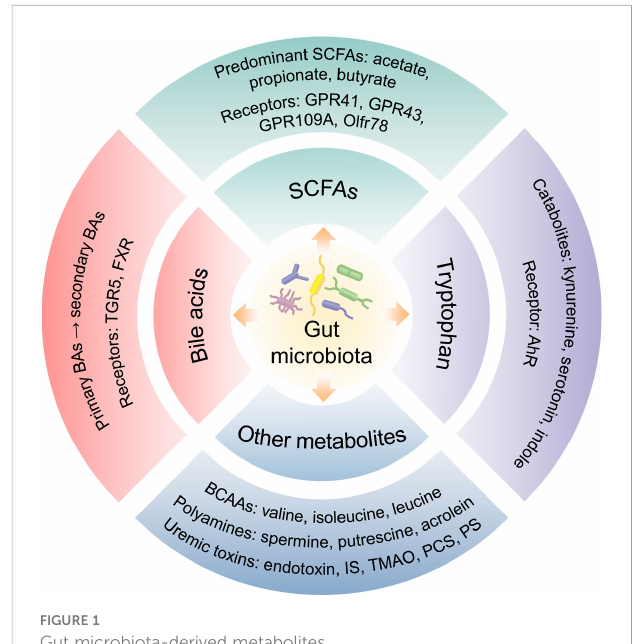
FIGURE 1 Gut microbiota-derived